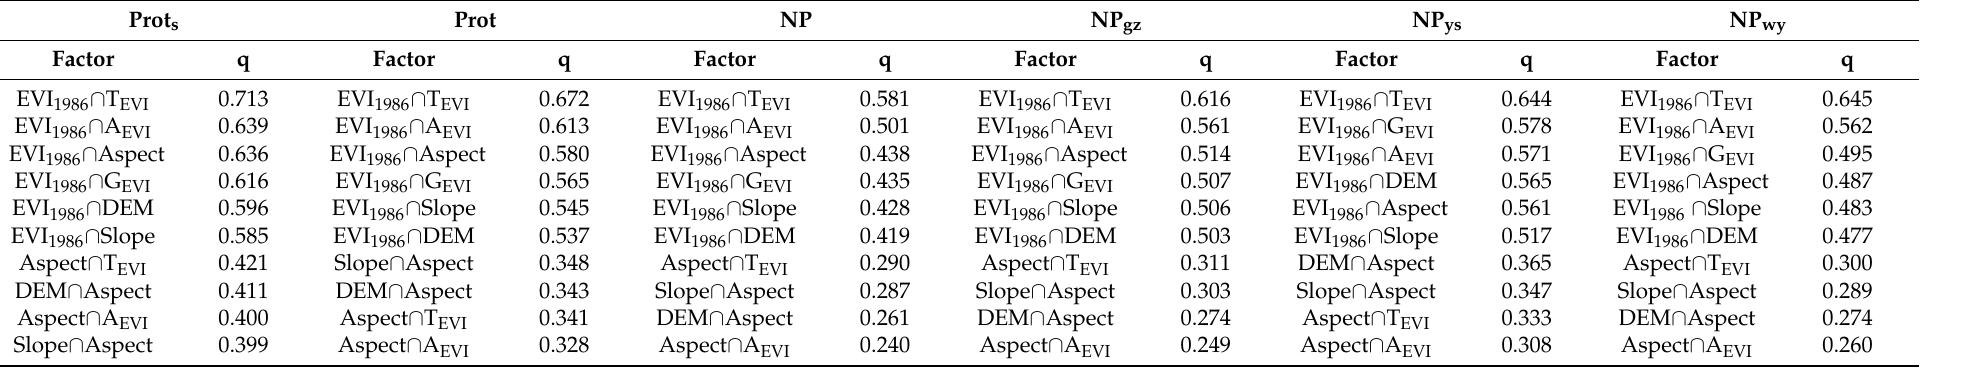
Table A1. Interaction detection in Wuyishan National Park during